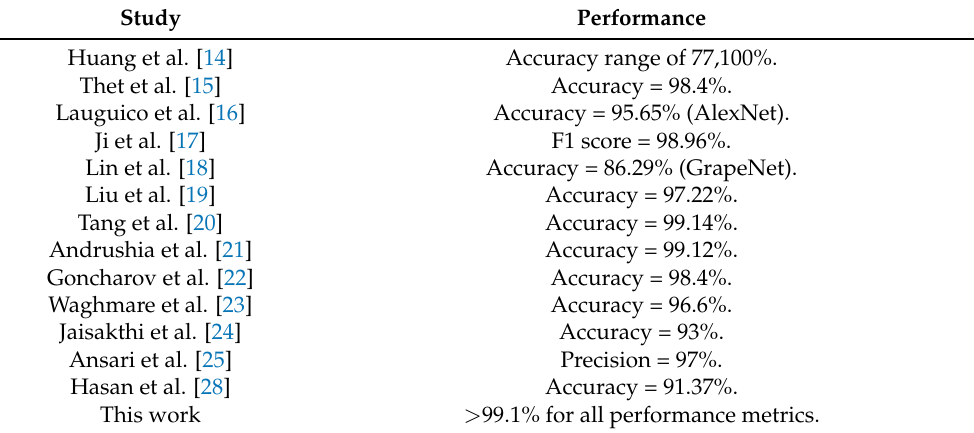
Table 7. State-of-the-art results in classifying grape diseases using leaf images. Study